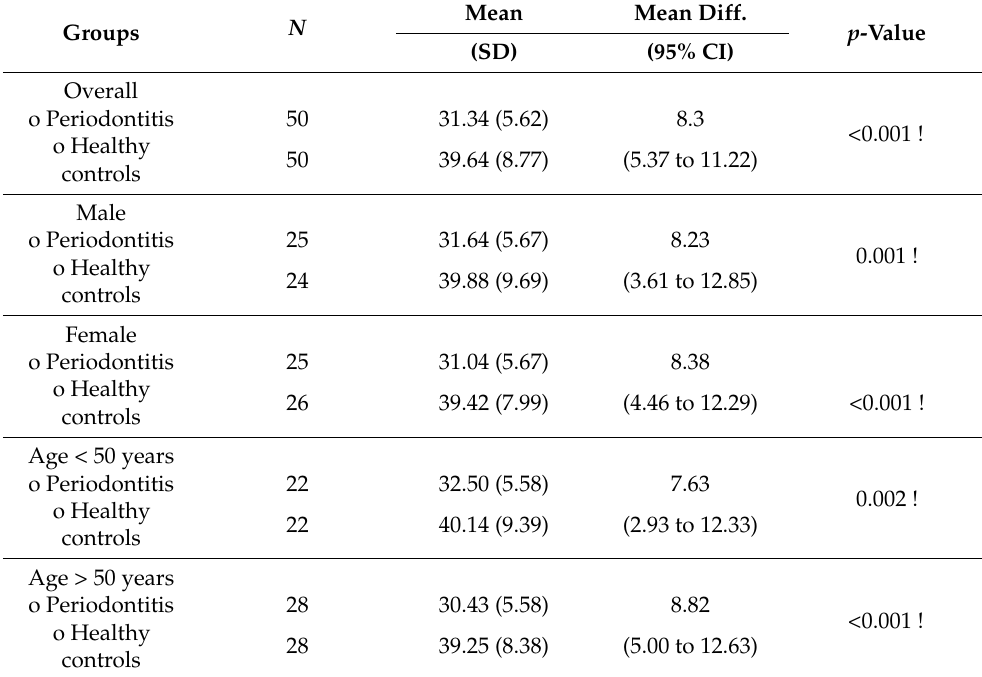
Vitamin D3 levels were measured in nmol/L; !— p -values for equal variance not assumed in multiple independent- samples t -tests with Bonferroni adjusted level of significance alpha = 0.01.